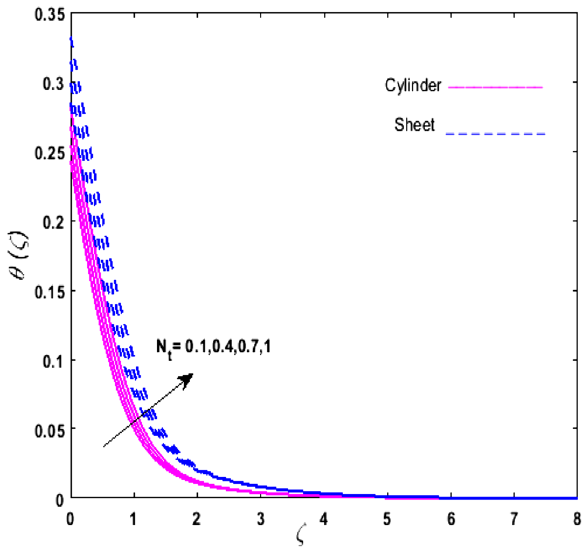
Figure 8. Upshot of N t on θ(ζ) .